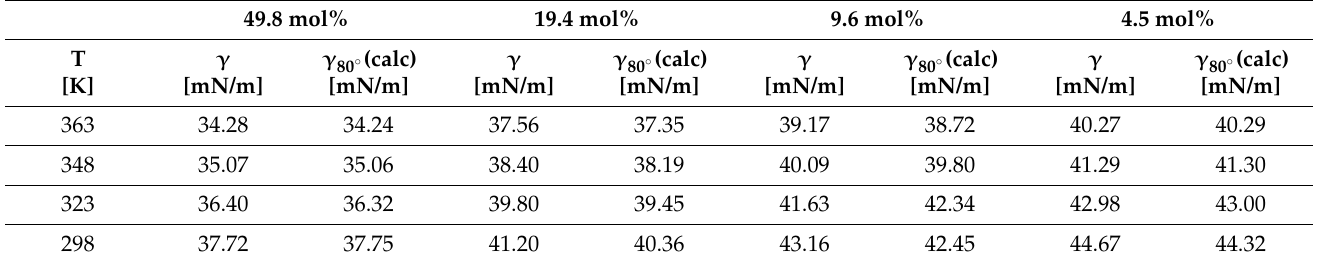
Table 2. Experimental ST values γ for different mixtures and temperatures (as derived from linear fits to the data according to Equation (1) with coefficients from Table 1), along with calculated ST values γ 80 ◦ (calc) using Equation (3) and the ARXPS 80 ◦ results shown in Figure 6b (see also bottom row of Table